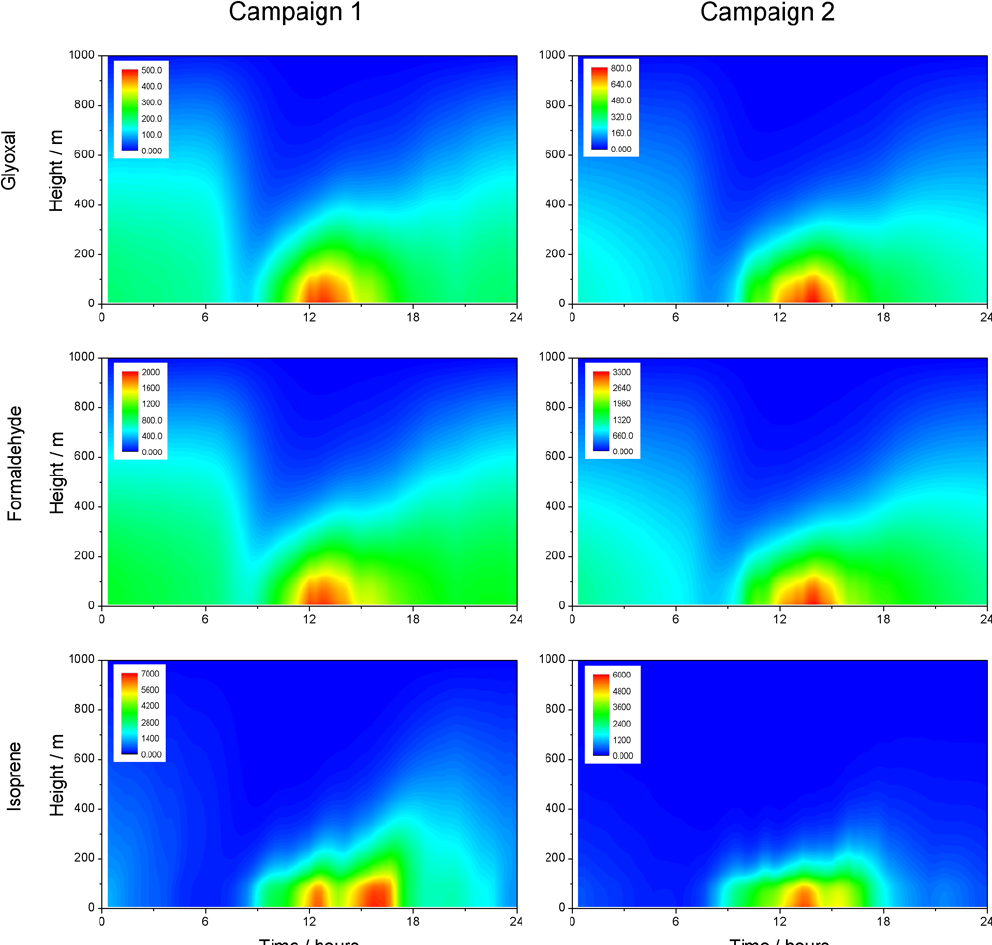
Fig. 11. Diurnal variations of the vertical profiles of glyoxal, formaldehyde and isoprene in the boundary layer, using a branching ratio of 8% for the glyoxal yield from